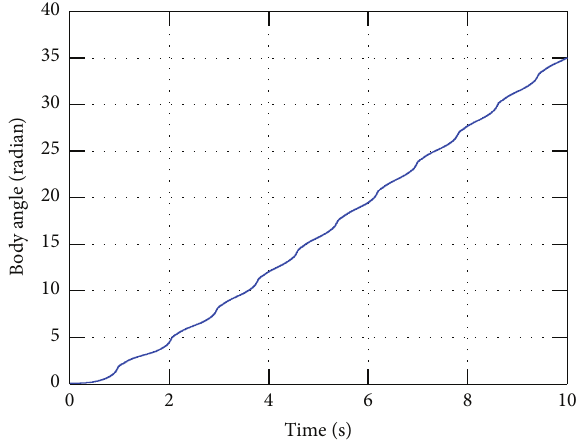
Figure 6: Rotational angle of the body. The rotational angle of the body increases over time. It means that the quadruped robot rolls continuously, and the robot rotates 5.57 times in 10s.